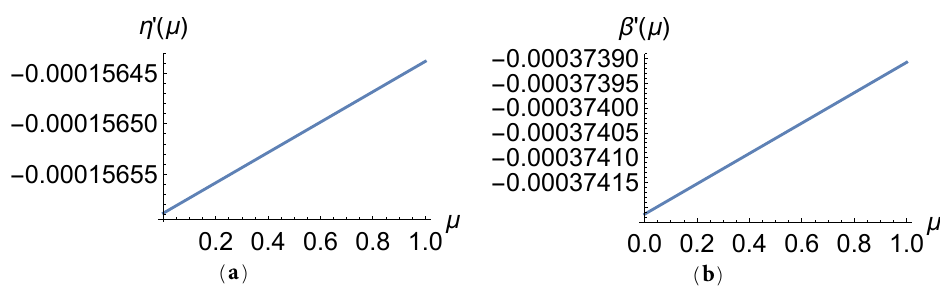
Figure 6. Numerical solutions of ( a ) η (cid:48) ( µ ) , ( b ) β (cid:48) ( µ ) demonstrating convergence as µ → 0, obtained using Mathematica. Parameter values are r e = 1.1, r d = 0.2, D e = 0.3, D d = 1.5, e = 0.001 and d = 0.00025.